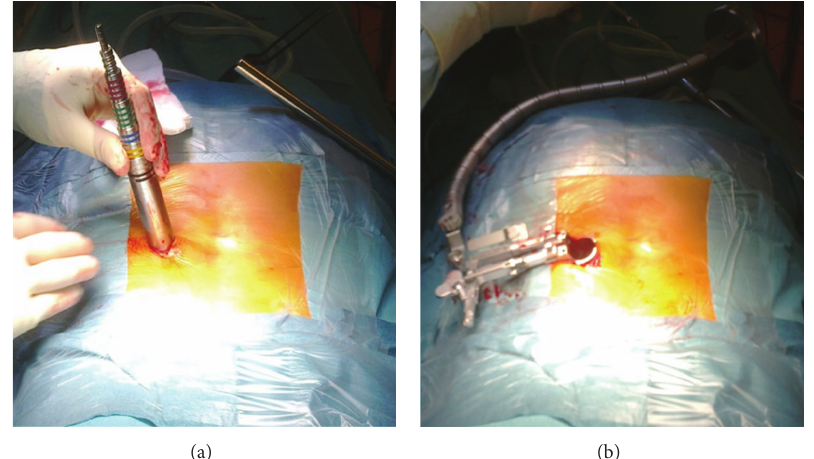
Figure 5: (a) Sequential muscle dilation and (b) expandable tubular retractor fixation to the articulated